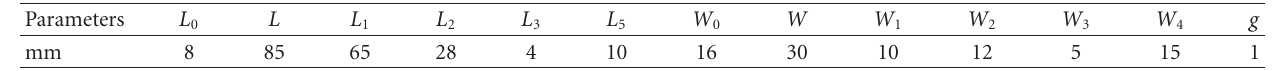
Table 1: Geometrical parameters of Figure 2.